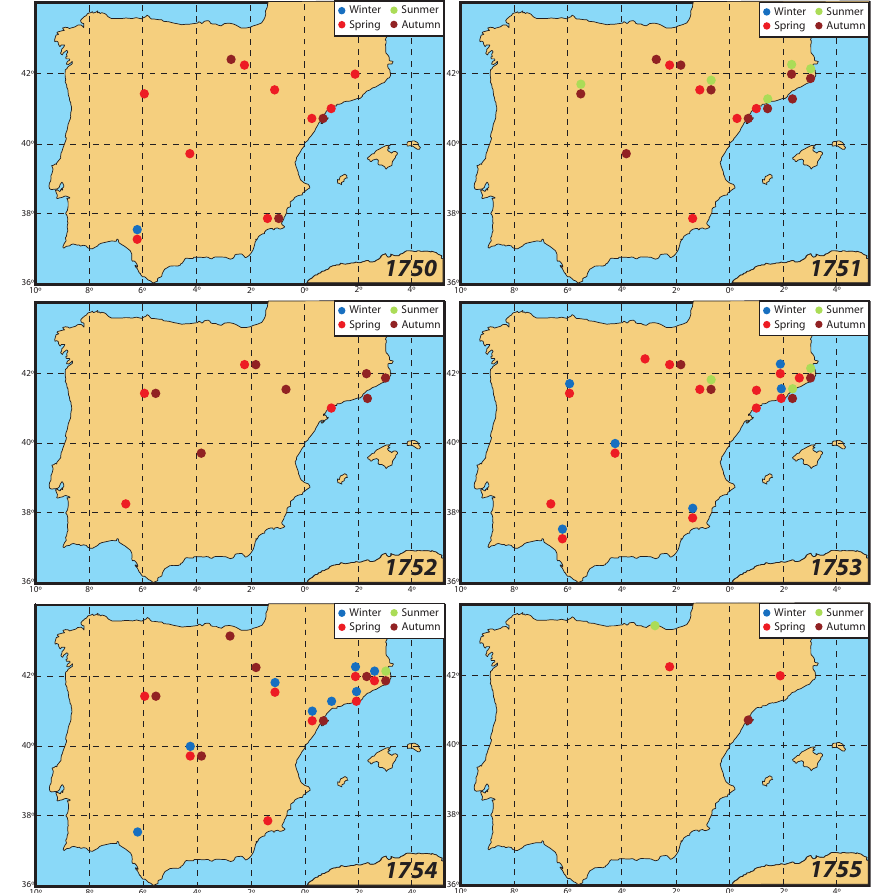
Fig. 4. Geographical distribution of rogations celebrated in Spain between 1750 and 1755.